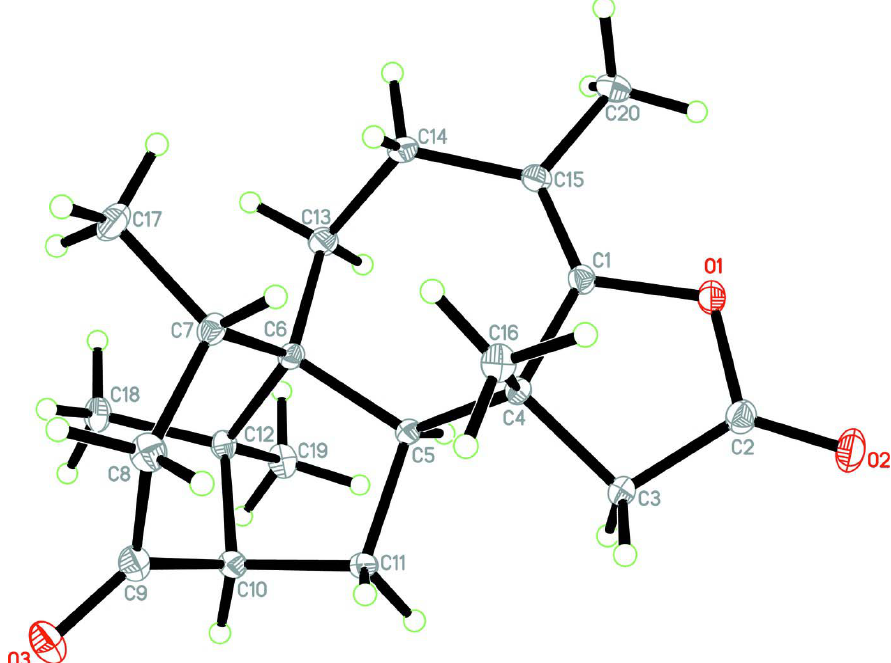
The molecular structure of the title compound, showing 40% probability displacement